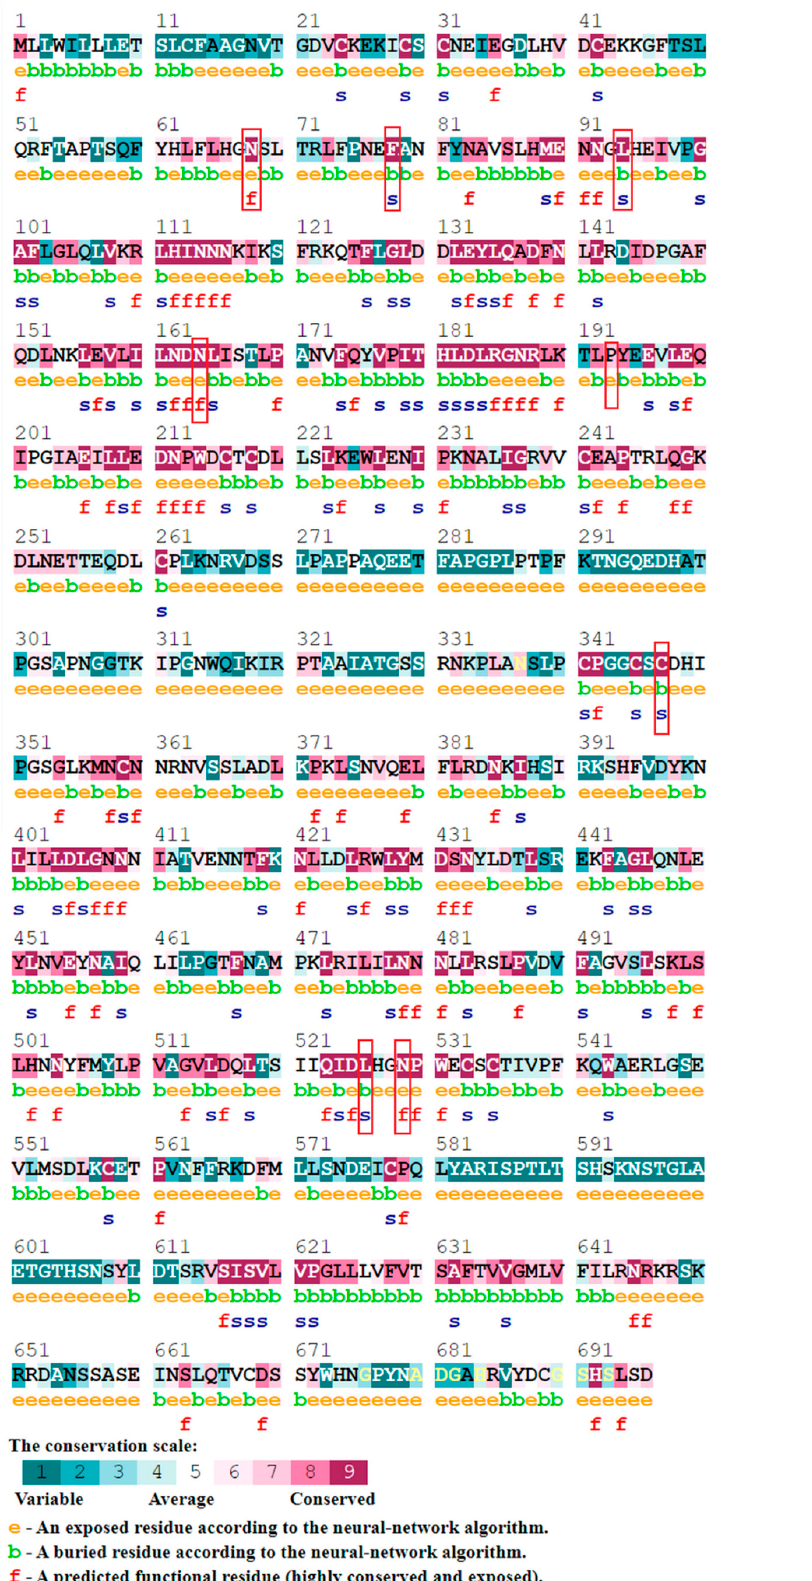
Figure 4. Evolutionary conservation analysis using ConSurf.